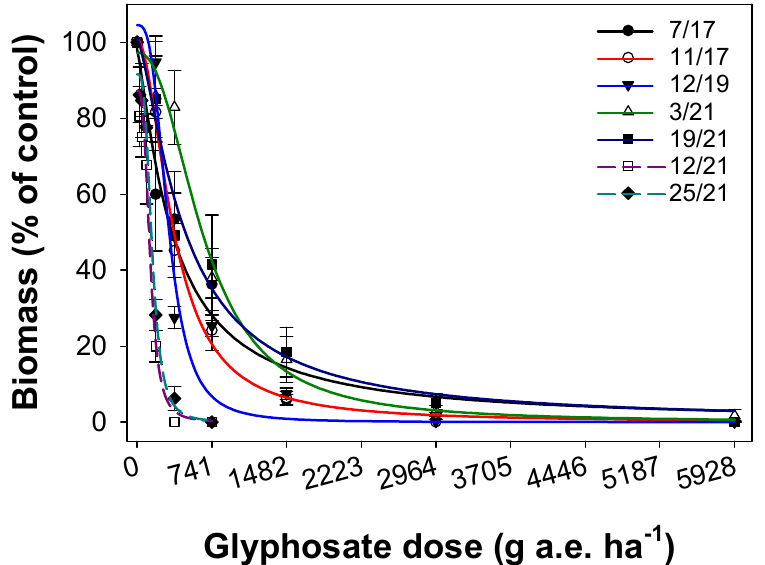
Figure 4. Effect of glyphosate dose on biomass (percent of control) of seven populations of Chloris virgata . The most susceptible population was 12/21. Plants were sprayed at the four–five leaf stage of each population. Table 2. Estimated glyphosate doses to kill 50% of the plants (LD 50 ) of seven populations of Chloris virgata , glyphosate doses required to reduce plant biomass by 50% (GR 50 ), and resistance indices (RI).